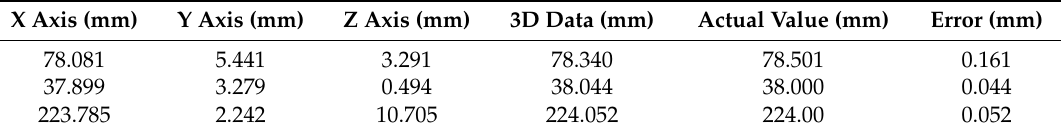
Table 5 . 3D measurement data and actual value. Table 5. 3D measurement data and actual value.